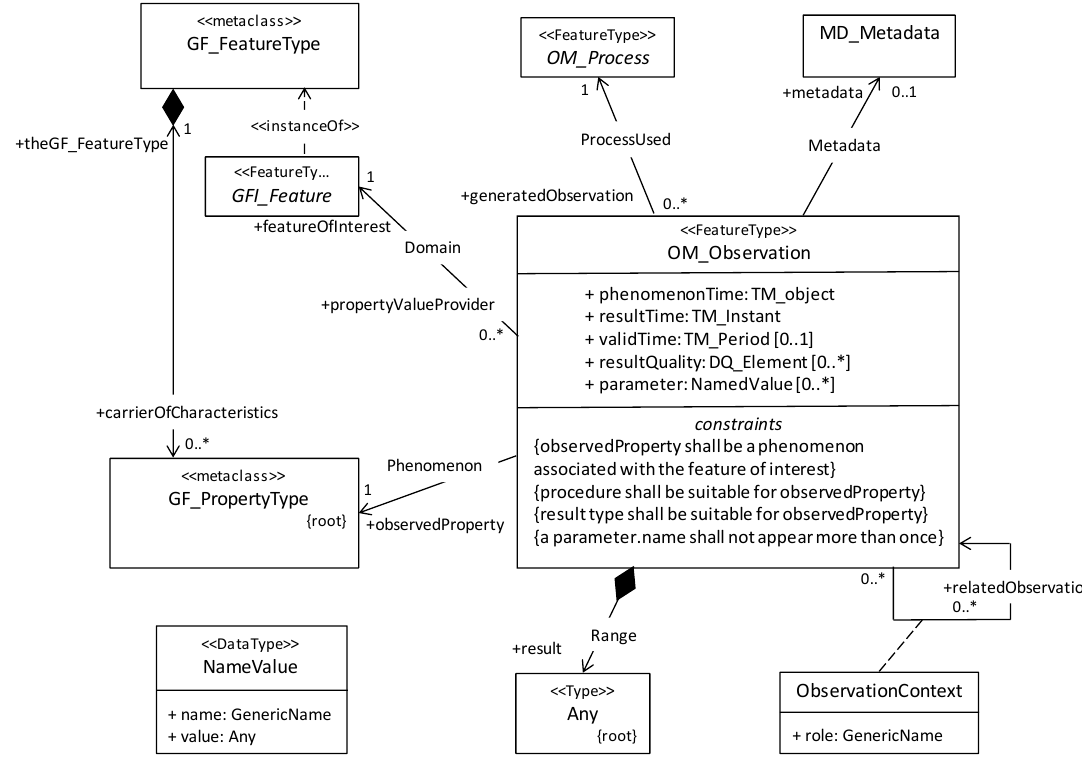
Figure 4. Core class diagram of Observation and Measurement O&M conceptual model [29].